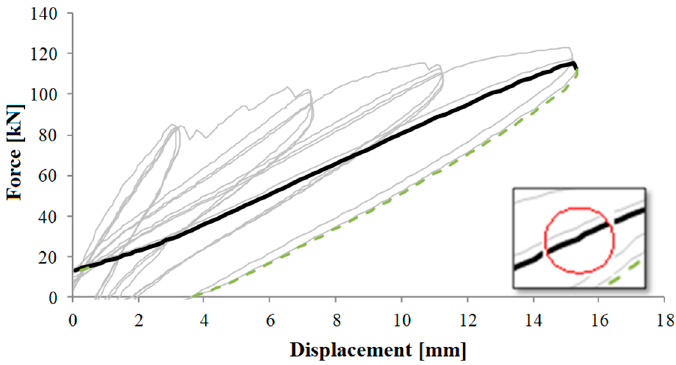
Figure 21. Load-displacement diagram at fourth drift (positive values)—circular